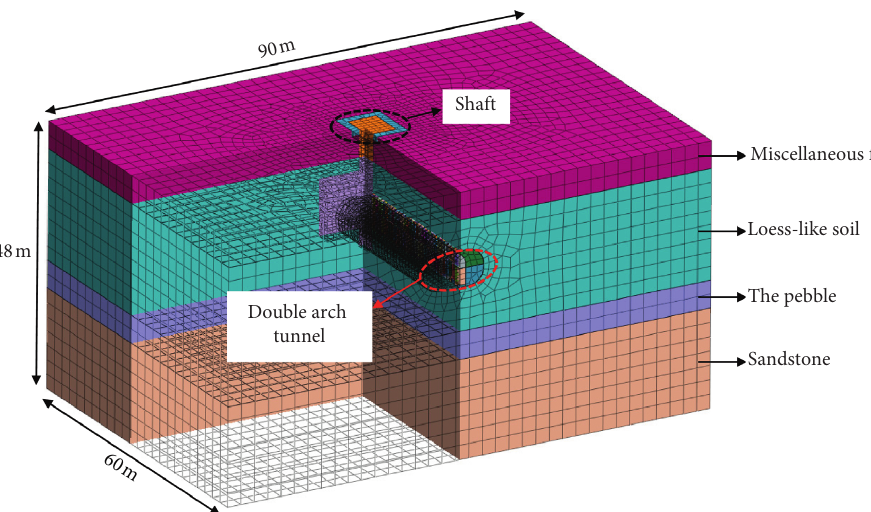
Figure 7: Numerical simulation calculation model and grid